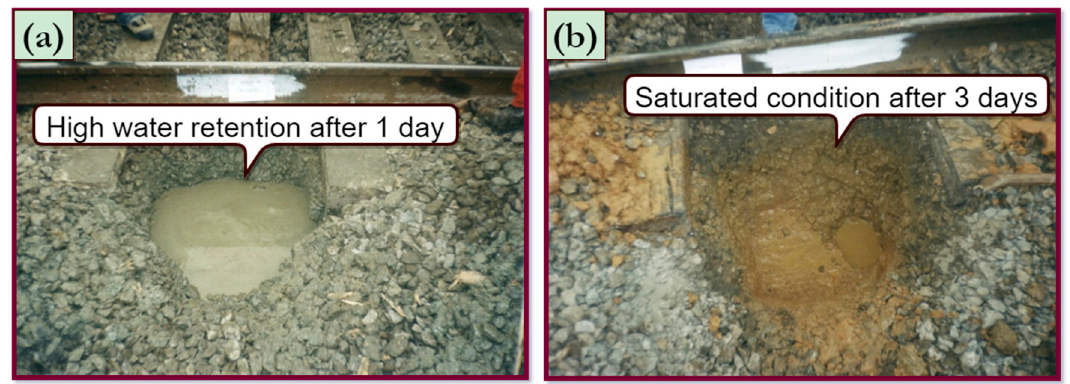
Figure 11. Low drainability of ballast after rainfall: condition after ( a ) one day and ( b ) three days [31].